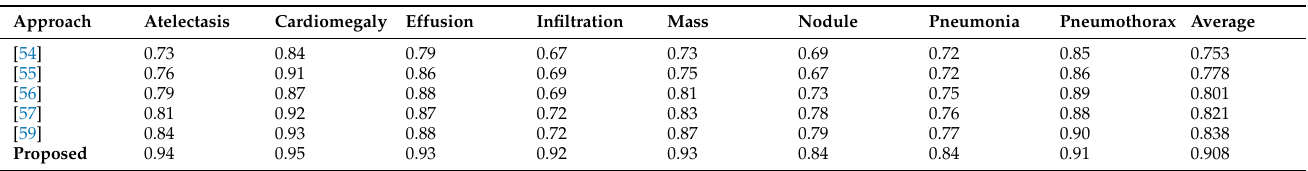
Table 7. Comparative assessment of the presented model with new techniques for the AUC metric.